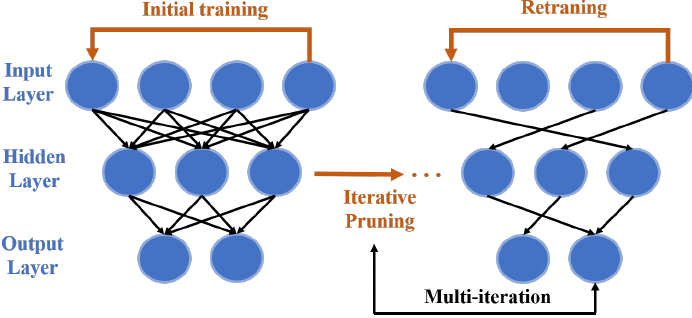
Figure 9. Iterative pruning process of the compressed FFNN